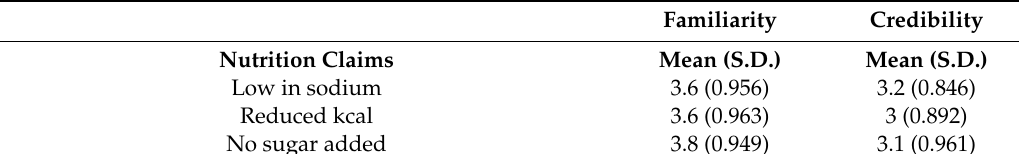
Table 3. Familiarity and credibility towards specific health and nutrition